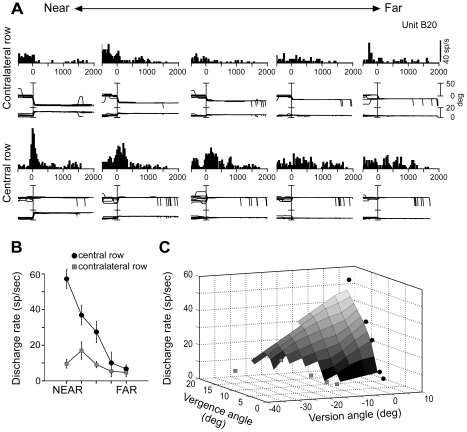
Example of a neuron with perisaccadic activity modulated by depth.(A): Spike histograms of neural responses, eye traces (version upper trace, vergence lower trace) to the five LEDs of the contralateral/central row arranged from near (left) to far (right), aligned at the start of the saccade. This cell shows a clear preference for saccades at the central and near space. (B): Mean± standard error (s.e.m.) discharge rates of the cell in (A) are shown for each LED of the contralateral (white rectangles) and central (black circles) row. (C): Three dimensonal plot obtained by interpolating mean discharge rates for the average value of vergence and version of each LED of the contralateral (white rectangles) and central (black circles) row. Vergence modulates this cell only along the midsagittal row.